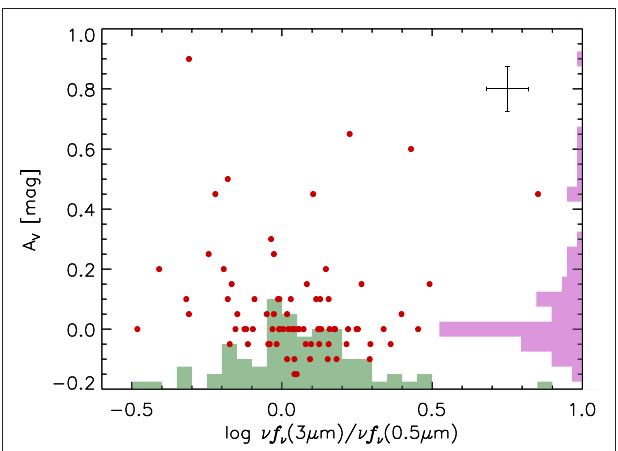
FIGURE 2 | Distribution of the extinction level applied to the disk component in the best fitting model and the dust-to-disk luminosity ratio for the whole sample of luminous quasars. Error bars in the top right corner indicate the typical uncertainties.